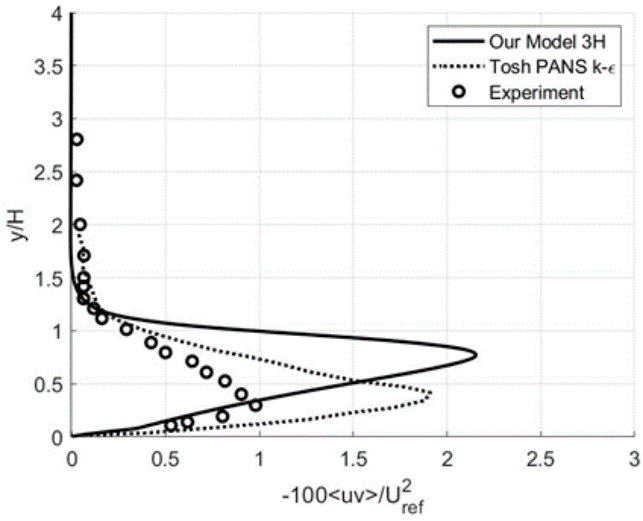
Figure 11. Mean Reynolds stress profiles at x / H = 5 from the step ( f ε = 0.667, f k = 0.2 ) .